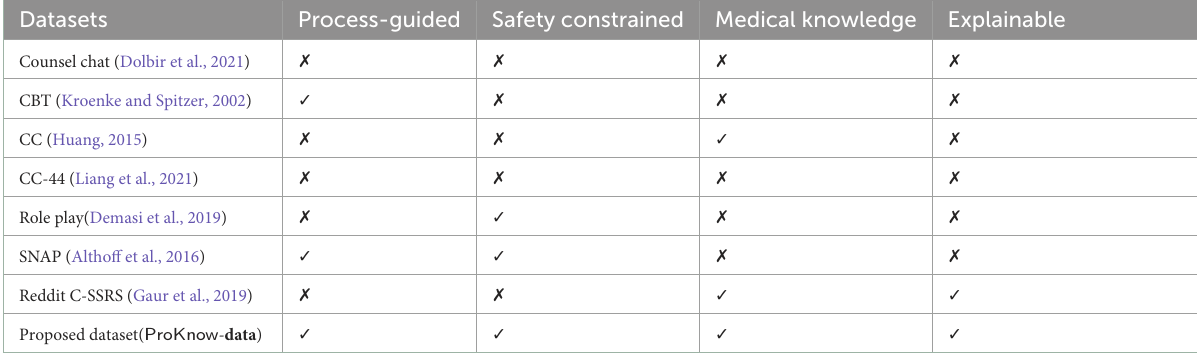
TABLE 1 3 Indicates a dataset has the feature, and 7 that it does not. Datasets Process-guided Safety